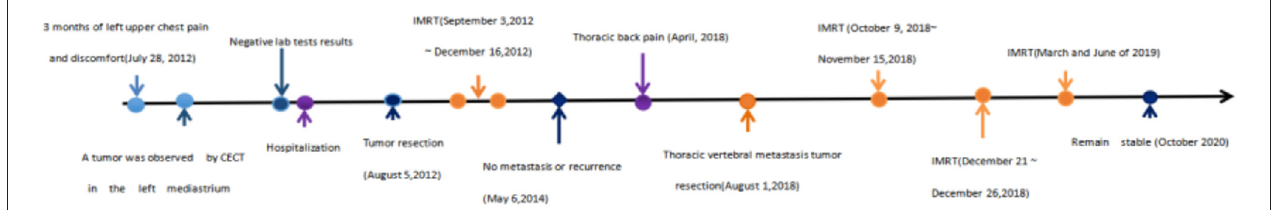
FIGURE 5 | The schedule of diagnosis and treatment of a 49-year-old female patient with mediastinal